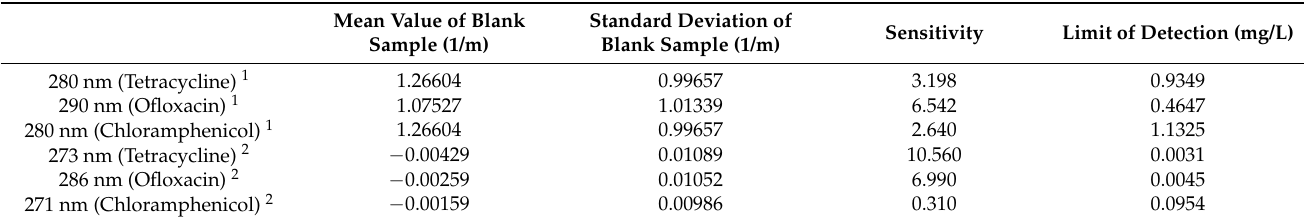
Table 3. Calculation parameters and limits of detection at different characteristic wavelengths.